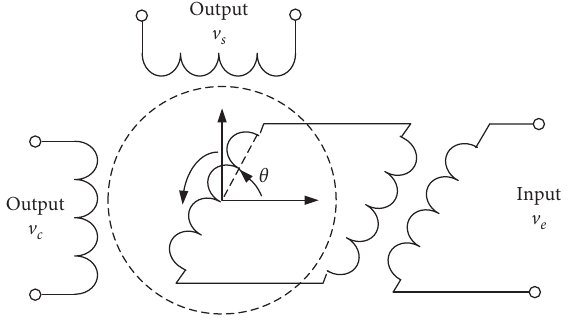
Figure 1: Schematic diagram of the